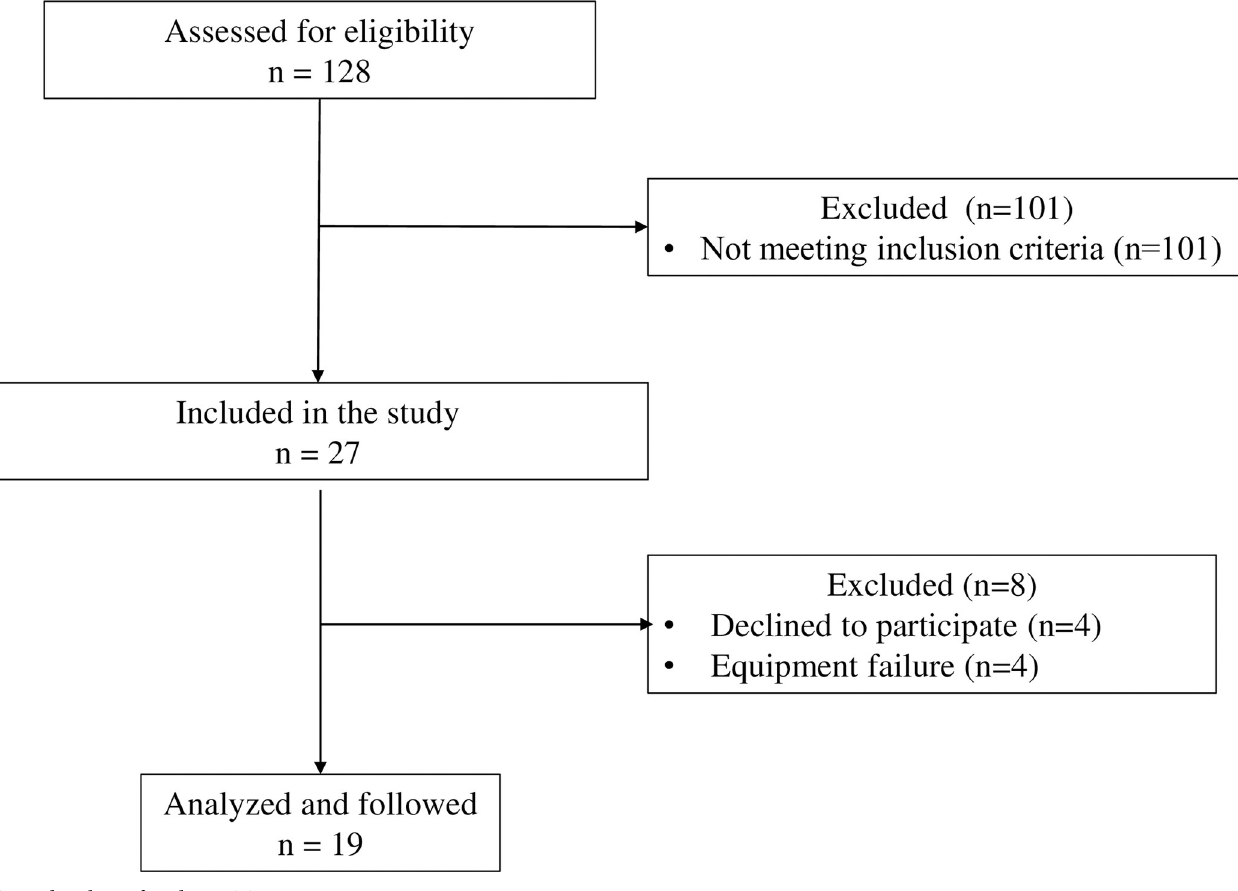
Fig 1. Flowchart of study participants.